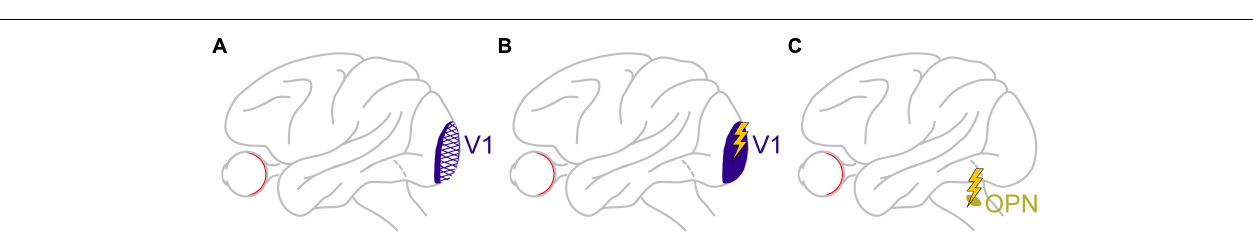
FIGURE 7 | Behavioral causal manipulation to isolate the influences of SC and FEF activity on cue-induced microsaccades. (A) Behavioral task to experimentally control the spatial landscape of visual and oculomotor activity (Tian et al., 2016). In control (left), a peripheral cue appeared during fixation and was maintained throughout trial duration. With real-time retinal-image stabilization, the fixation spot and cue were experimentally pegged on the retina (that is, moved with the eye). Thus, a cue-induced early microsaccade did not generate a foveal position error at fixation that needed to be corrected; on the other hand, it could move the peripheral stimulus even farther out on the display (potentially rendering it invisible beyond the display edge if there was no top-down compensation that is implemented). (B) In control (left panel), a plot of microsaccade direction distributions reveals a similar oscillation to Figure 1 : first, there was a bias of movements toward the cue (blue curve elevating above the horizontal black dashed line), and then there was a bias of opposite movements (red curve elevating above the horizontal black dashed line). With retinal-image stabilization (right panel), the early cue-induced effect was amplified. This was because the spatial layout of the peripheral stimulus onset was no longer competing with other factors like foveal position error at the fixation spot, which was uncontrolled in the control condition. Moreover, for subsequent microsaccades, there was a strong bias opposite the cue. Without such a bias, the peripheral stimulus could eventually have moved out of the display if all microsaccades continued to be toward the cue. Therefore, this causal manipulation further highlights the notion that post-inhibition microsaccades require top down strategic control, whereas early cue-induced microsaccades (during microsaccadic inhibition) are more reflexive (and likely subcortically mediated). Adapted with permission from Tian et al.